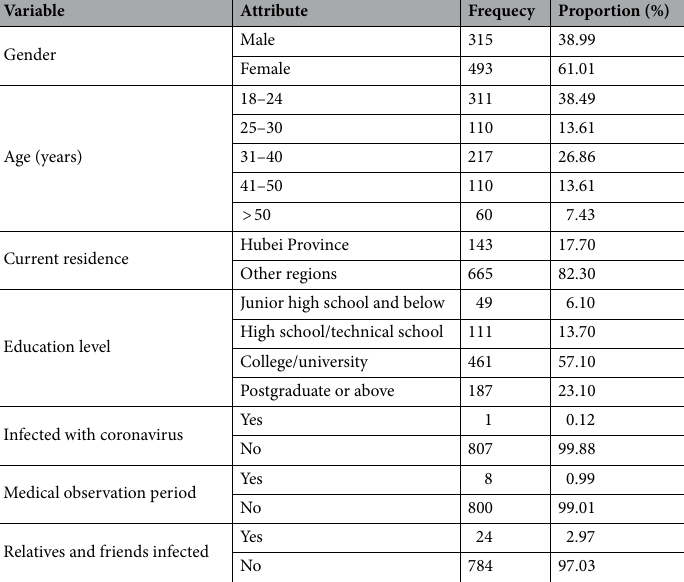
Table 2. Participants’ demographic characteristics (N =